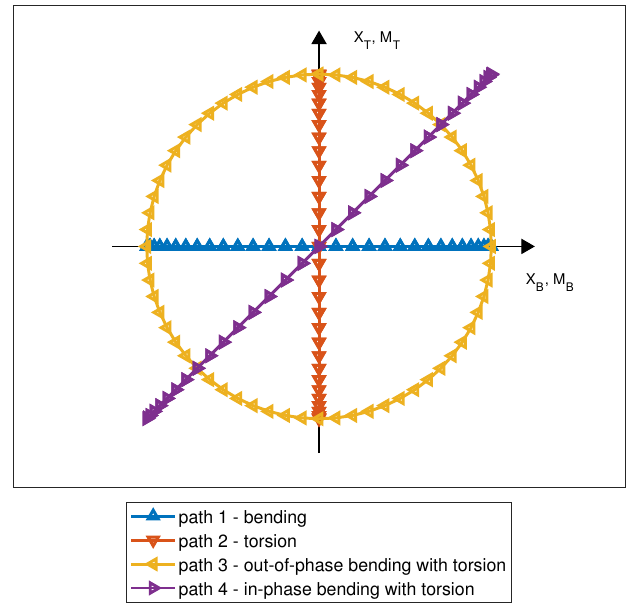
Figure 4. Loading paths.